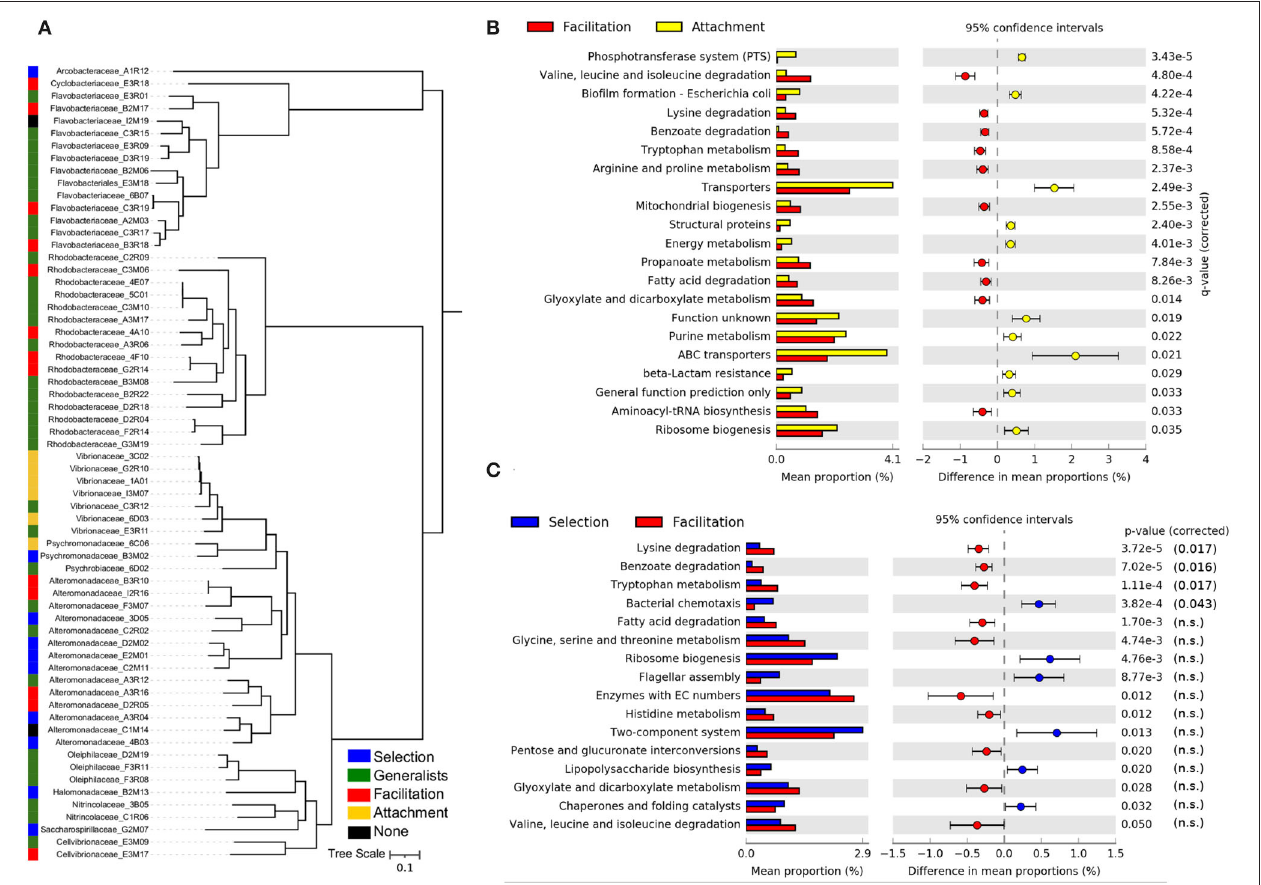
FIGURE 5 | Ecological strategies of isolated strains. (A) Phylogenetic tree of the isolates used in this study, inferred from multiple sequence alignment of the 120 GTDB-Tk bacterial marker genes present in sequenced isolate genomes. The predicted taxonomic family and strain identity is indicated in the leaf label. The ecological strategies of the isolates inferred from the trajectories of the ESVs with 100% sequence identity in the 16S amplicon sequencing experiments are shown in different colors. Differences in the mean proportions of genes grouped in KEGG pathways between isolates identified as having a preference for the attachment phase and those with a preference for the facilitation phase (B) and the same comparison between isolates with a preference for the selection phase and those with a preference for the facilitation phase (C) . The first column represents the mean proportions of the genes in the pathway for each group of isolates, and the second column represents the difference between those proportions. Adjusted Benjamini-Hochberg p -values and 95% CI intervals are indicated. Only pathways with effect sizes larger than 0.1 are